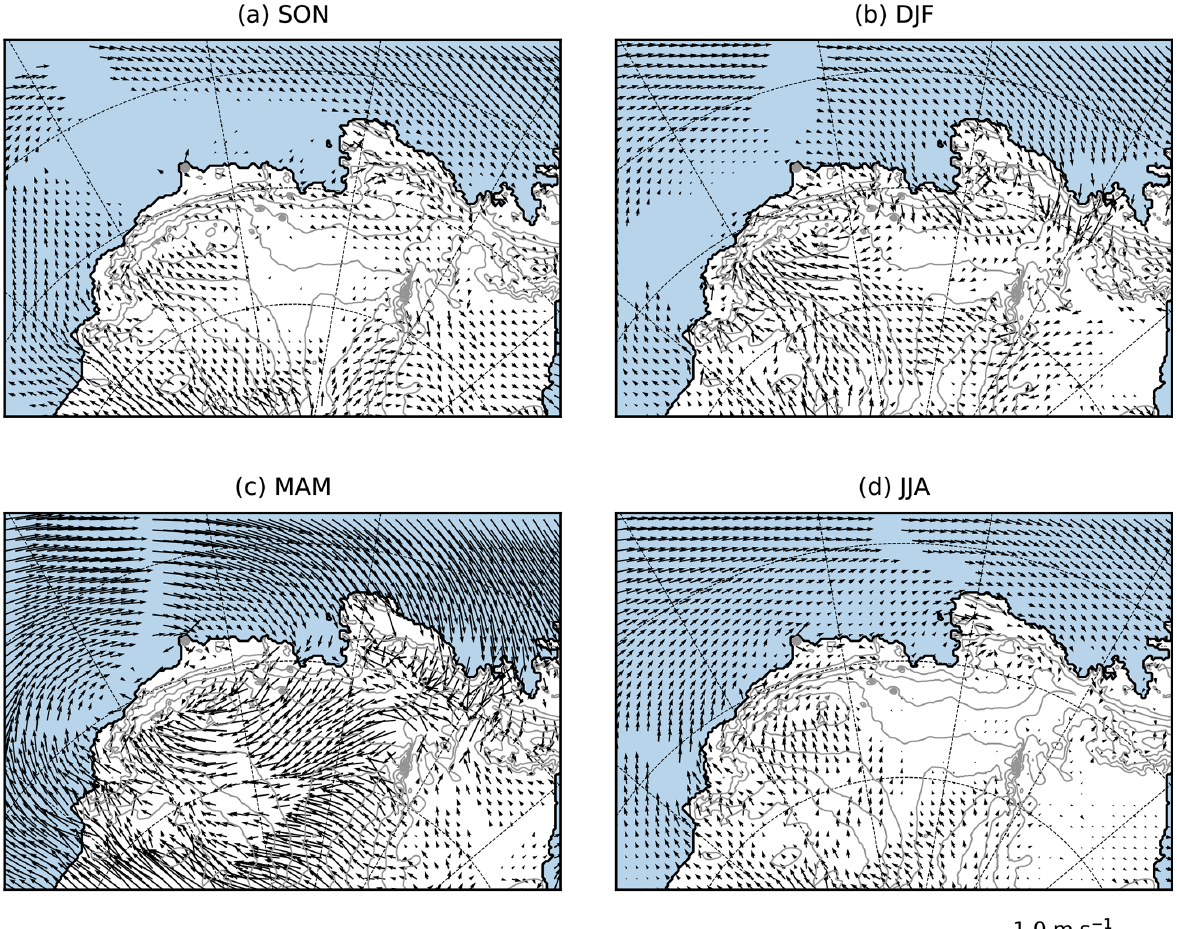
Figure 5. Changes in mean seasonal 10m winds (future minus present). Vectors are not displayed at locations where the change in at least one of the wind components is not statistically significant ( t test on 3-month means with a p value of 0.05). The open ocean is in light blue, and the ice-sheet topography is shown in grey (contours every